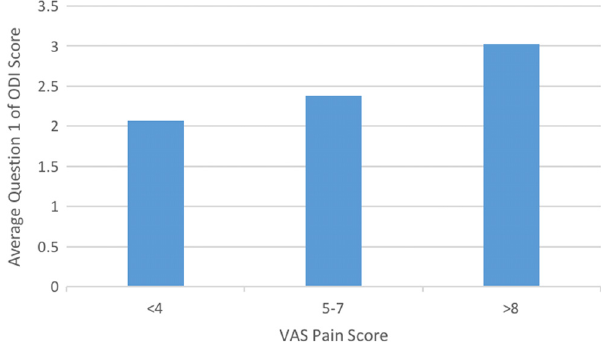
Figure 3. Graph comparing VAS pain score with average question 1 score of the ODI.